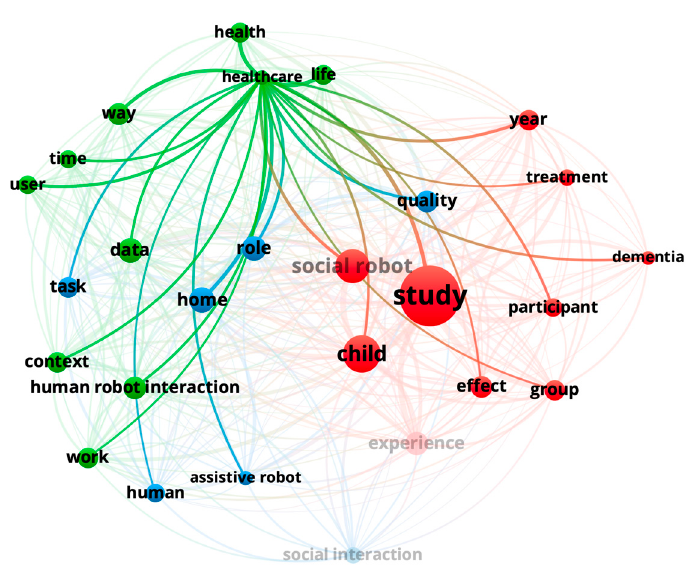
Figure 5. Healthcare cluster.